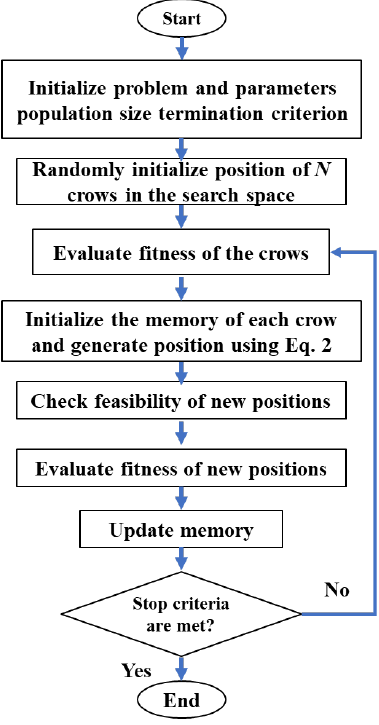
Figure 1. Crow flowchart algorithm.